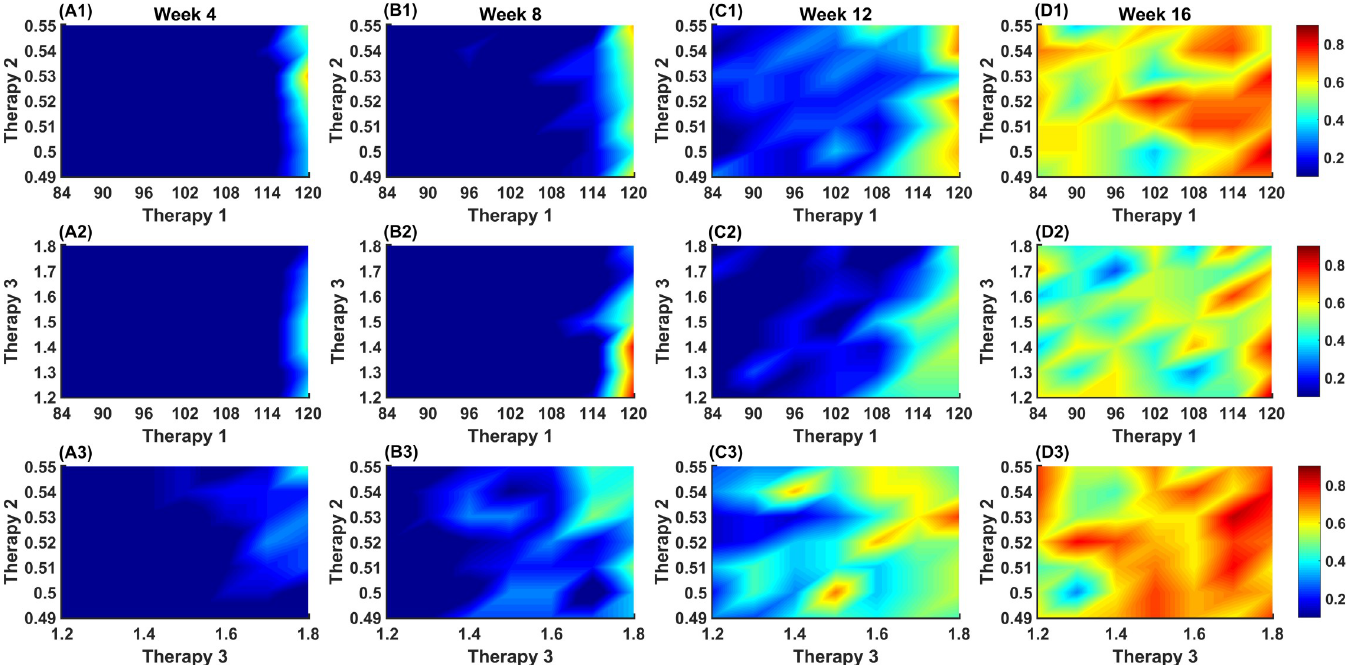
Fig 9. Probability of developing T1D based upon combinations of proposed therapeutic strategies. Therapeutic interventions were implemented based upon single dosage regimens starting at week 4 (Panels A1-A3) to week 16 (Panels D1-D3). Therapy 1 represents a certain strategy that reduces the residence of CTLs in islets. Therapy 2 is described as an intervention that can inhibit DC infiltration into islets. Therapy 3 denotes a strategy that prohibits binding sites on DCs for na ï ve CD8 + T cells.